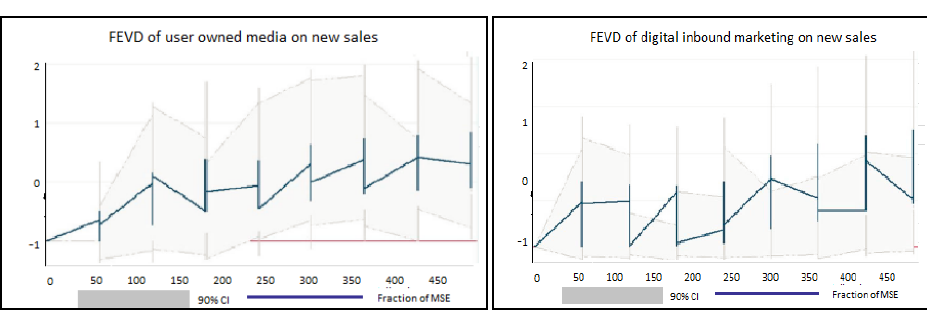
Figure A1. FEVD of new sales by digital inbound marketing.